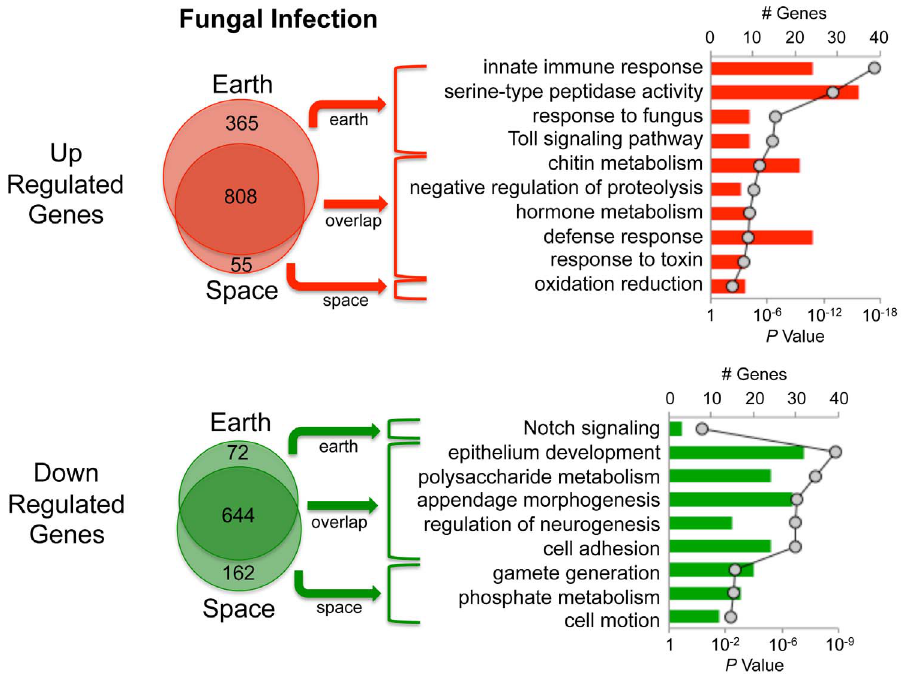
Figure 2. Microarray-based analysis of response to B.bassiana . The total number of genes upregulated or downregulated in Earth flies only (Earth) or space flies only (Space) or in both (overlap) are indicated by Venn diagrams. Pathway analysis of each of these groups is shown on the right side of the figure. The number of genes in each functional category is depicted in bar graphs (primary y-axis), and the P values corresponding to statistical over-representation of each category are presented as a line graph (secondary y-axis). Note that certain genes annotated into more than one of these categories.